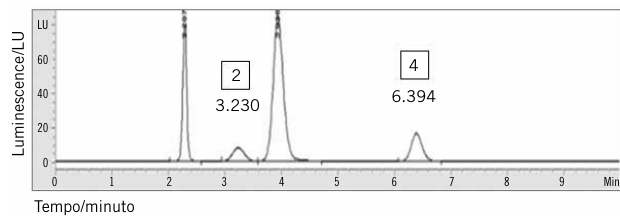
figurE 1 − Homocysteine chromatogram determined from analysis of plasma homocysteine of studied patients (2) homocysteine analytical study; (4) cystenine analytical study.